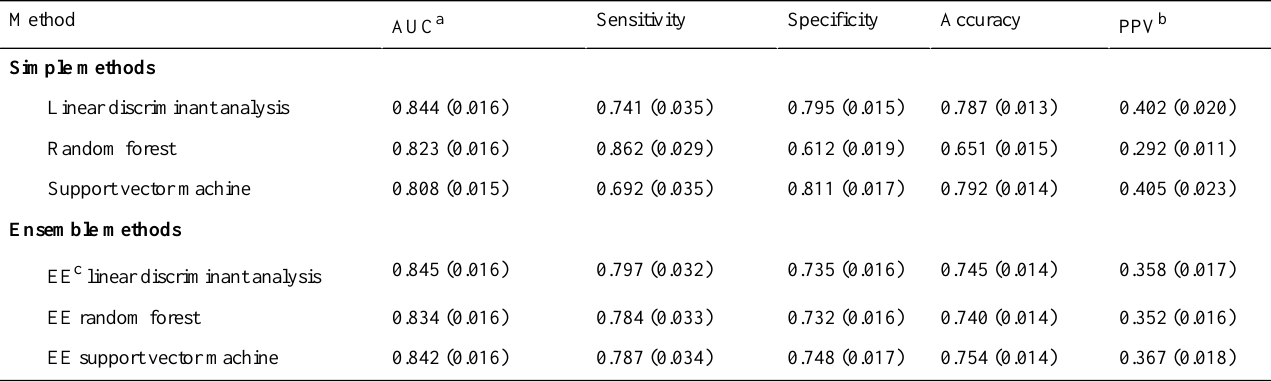
Table 2. Average results (SD) of the 5-fold cross-validation of the models in the training set.